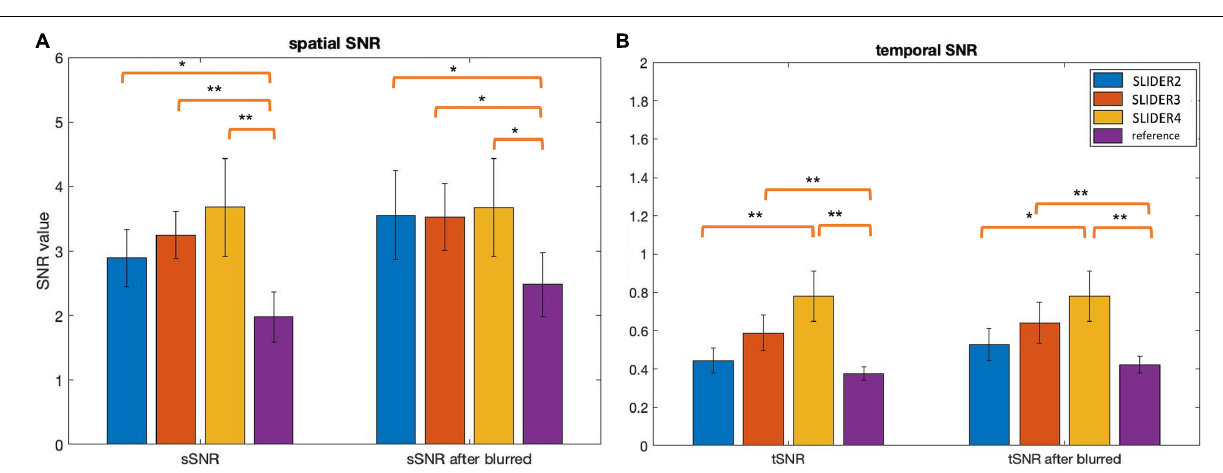
differences between SLIDER3/4 and reference ( p < 0.05